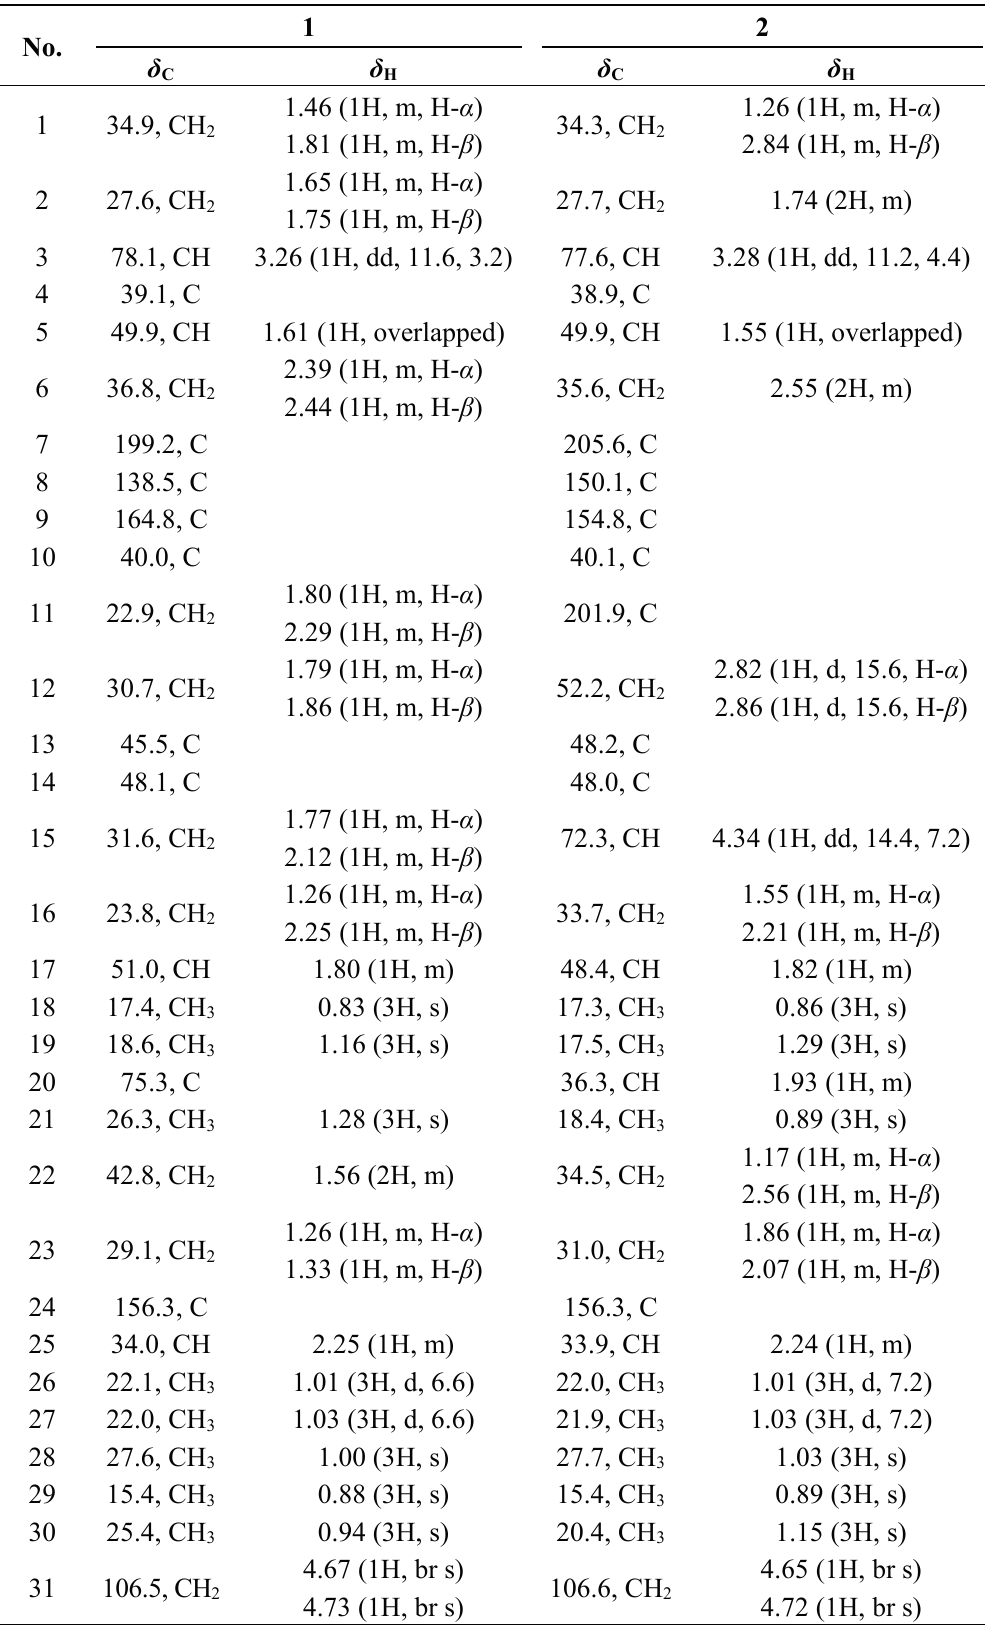
Table 1. NMR data for compounds 1 – 2 ( δ in ppm J in Hz, in CDCl 3 , 400 and 100